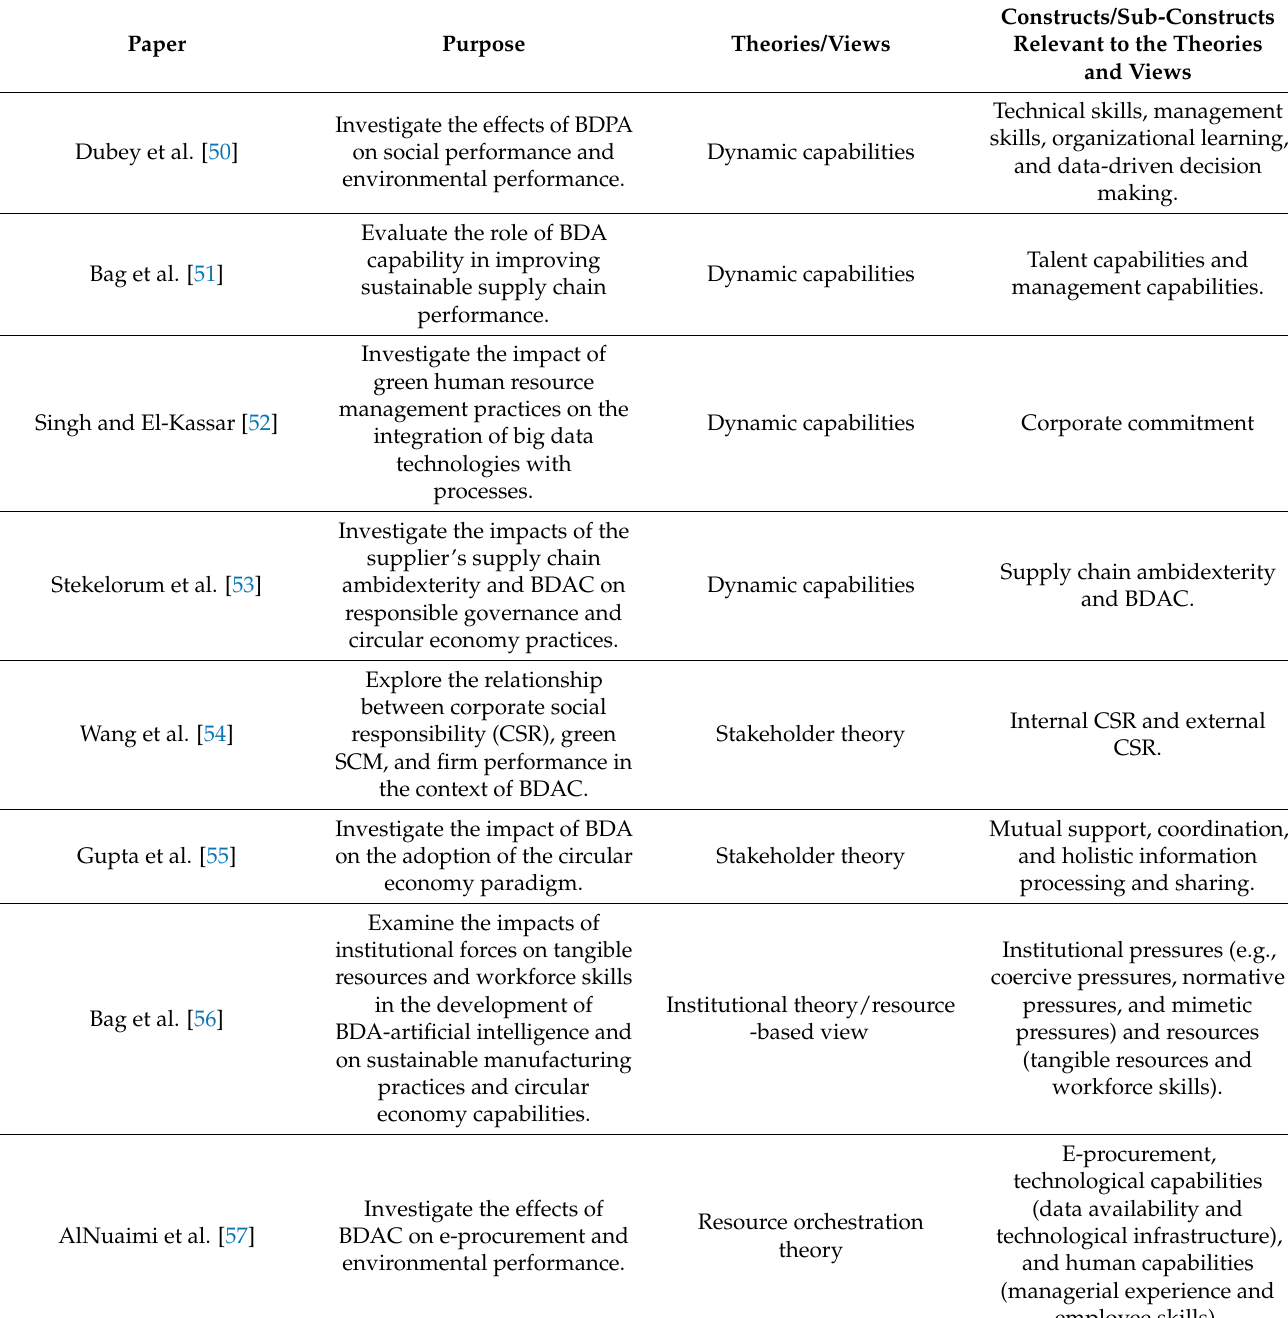
Table 5. Paper, purpose, theories/views, and constructs/sub-constructs of